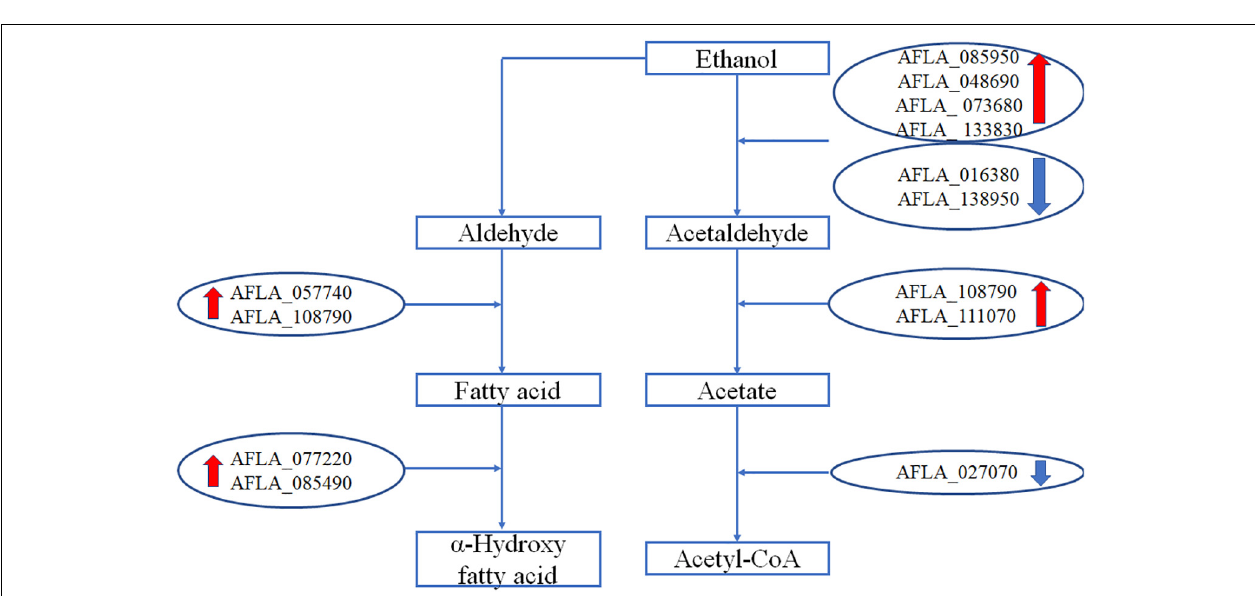
FIGURE 4 | The differential expression of genes in aflatoxin biosynthesis cluster in response to 3.5% ethanol. ns, not significant; ∗ p < 0.05; ∗∗ p < 0.01.